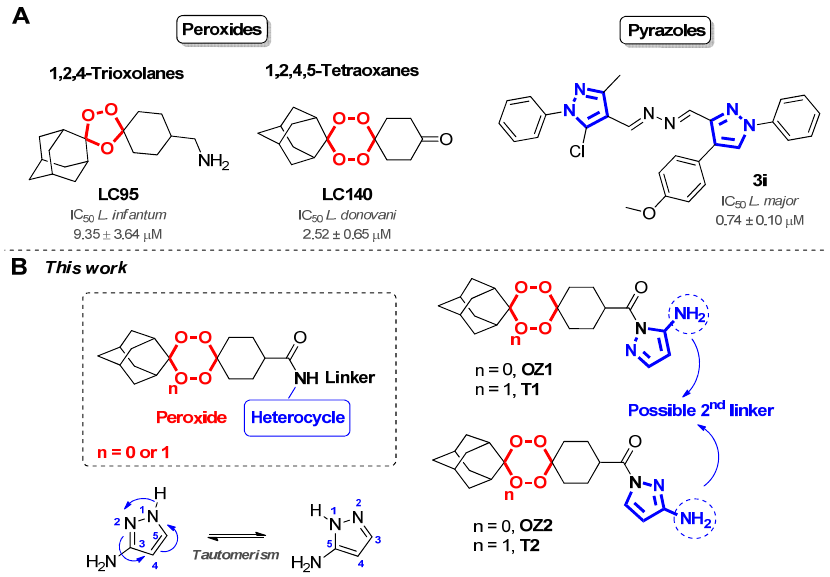
Figure 1. Structures of: ( A ) 1,2,4-trioxolane LC95 [5], 1,2,4,5-tetraoxane LC140 [1], and pyrazole derivative 3i [17], with known antileishmanial activity; and ( B ) 1,2,4-trioxolane-3(5)-aminopyrazoles ( OZ1 , OZ2 ) and 1,2,4,5-tetraoxane-3(5)-aminopyrazoles ( T1 , T2 ) reported in this